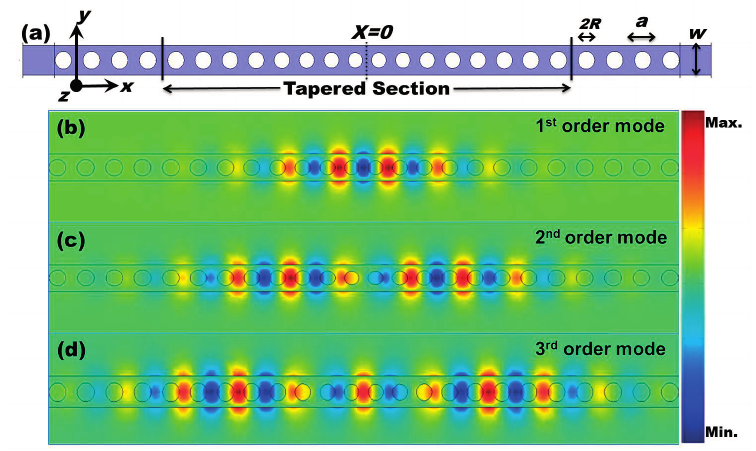
Figure 1. ( a ) Schematic of the single PhC NB cavity; ( b – d ) mode profiles of the electric field components Ey for the first, second, and third order mode,